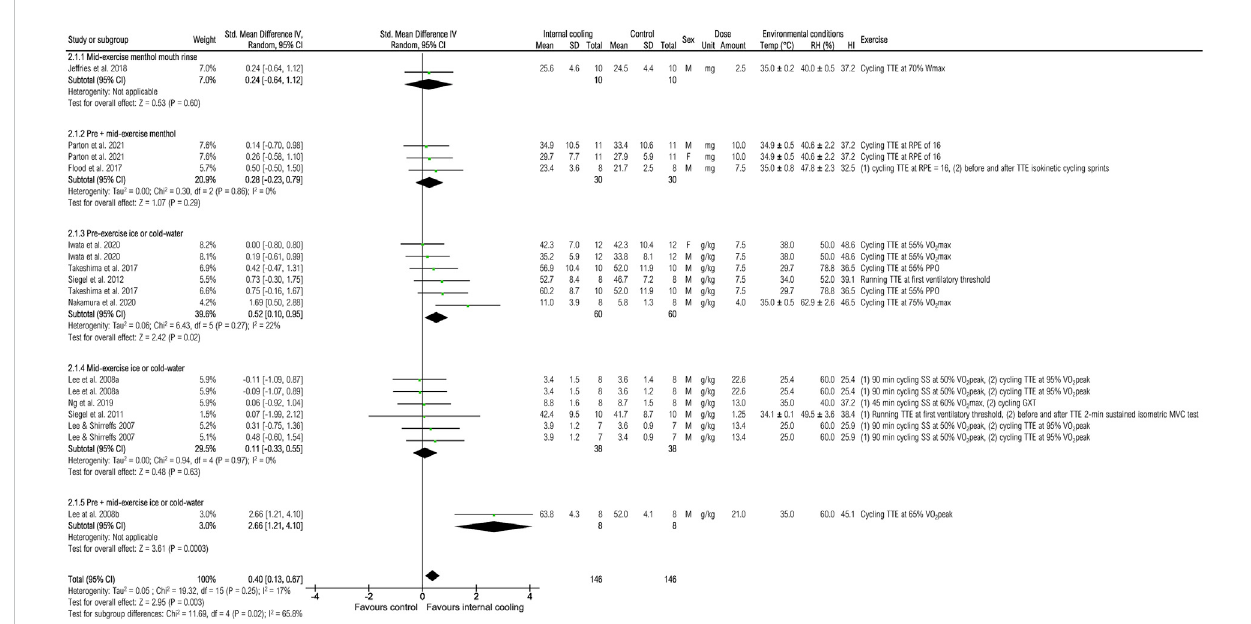
FIGURE 3 Meta-analysisofstandardizedmeandifferenceintimetoexhaustion[min]with95%CIbetweeninternalcoolingandcontrol.F,female;GXT,graded exercise test; HI, heat index; M, male; MVC, maximum voluntary contraction; PPO, peak power output; RH, relative humidity; RPE, rate of perceived exertion; SS, steady-state exercise; Temp, ambient temperature; TTE, time to exhaustion; VO 2 max, maximum oxygen consumption; VO 2 peak, peak oxygen consumption; Wmax, maximum power.